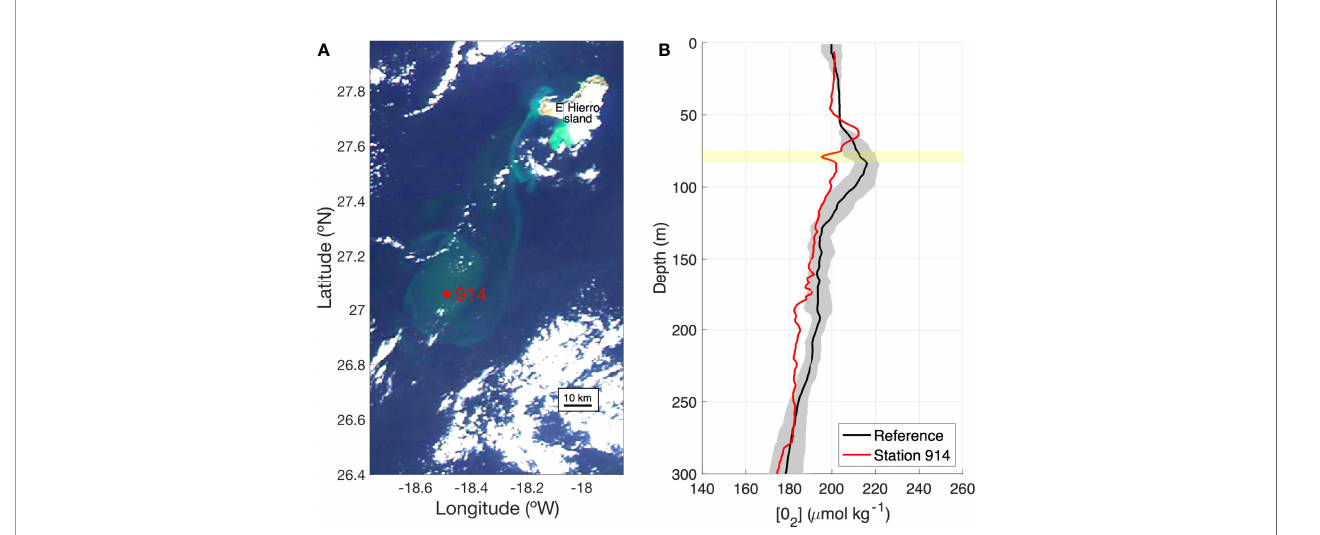
FIGURE 4 | Dissolved oxygen in a plume transported 80 km southwest of the volcano by an anticyclonic eddy. (A) True color satellite image from November 5 th 2011. (B) Vertical pro fi le of dissolved oxygen within the transported plume. Black line shows a reference pro fi le with standard deviation (grey shadow). A yellow stripe highlights the peak corresponding to the anomaly transported from the